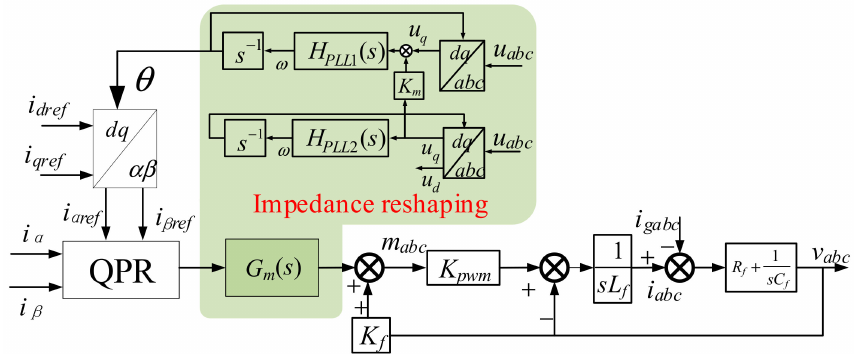
Figure 6. Proposed resonance suppression method based on impedance reshaping.